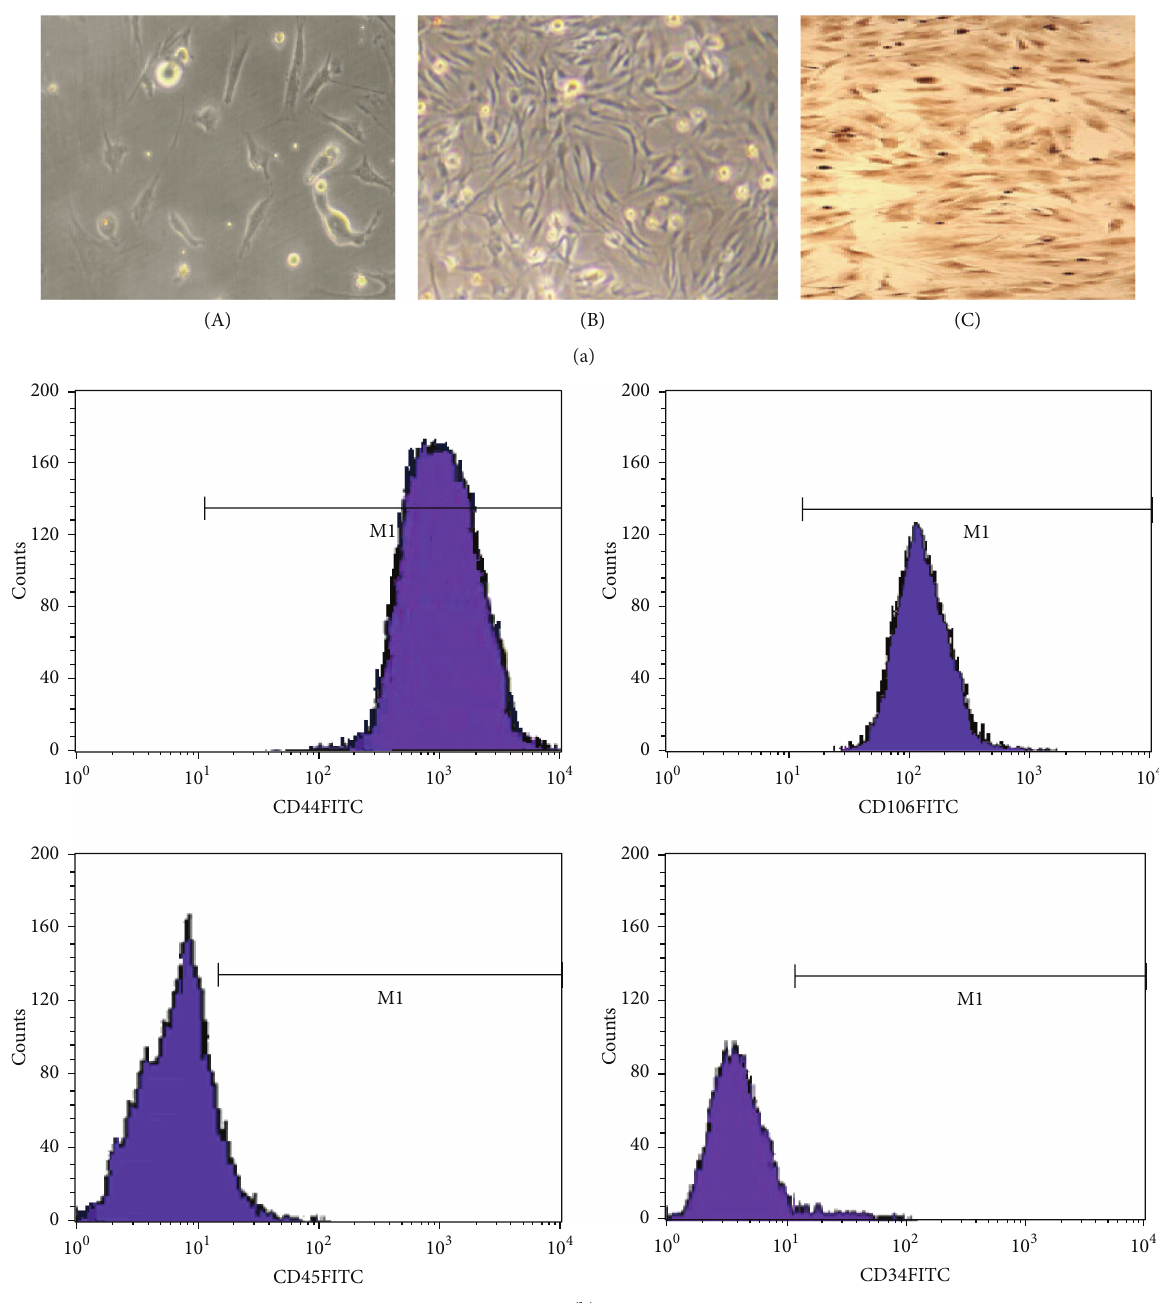
Figure 2: Characteristics of cultured BMSCs of morphology and immunophenotyping. (a) Morphology and immunocytochemistry staining of BMSCs. (A) The primary cultured BMSCs showed adherence to the culture dish displaying short bar shapes. (B) The 2-3 generations of BMSCs transformed into long spindles with vortex shape. (C) Immunocytochemistry expression of CD44 in the 3rd generation of BMSCs ( × 100). (b) Flow cytometry analysis of immunophenotype of